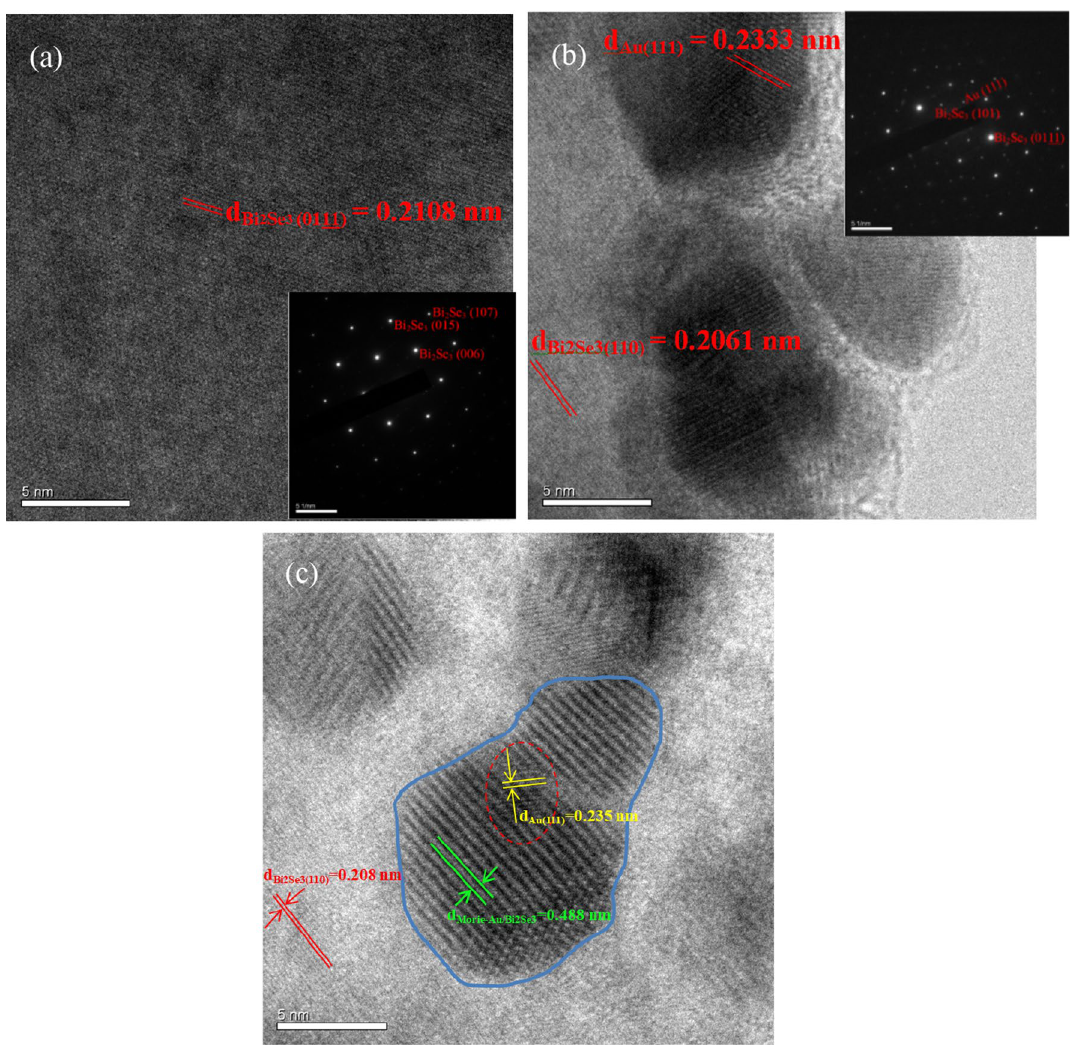
Figure 3. HRTEM images of ( a ) pristine Bi 2 Se 3 , ( b ) Au180s-decorated Bi 2 Se 3 NPs. Insets are the SAED patterns, and ( c ) the Moiré pattern originating from the superposition of the lattices of Bi 2 Se 3 and